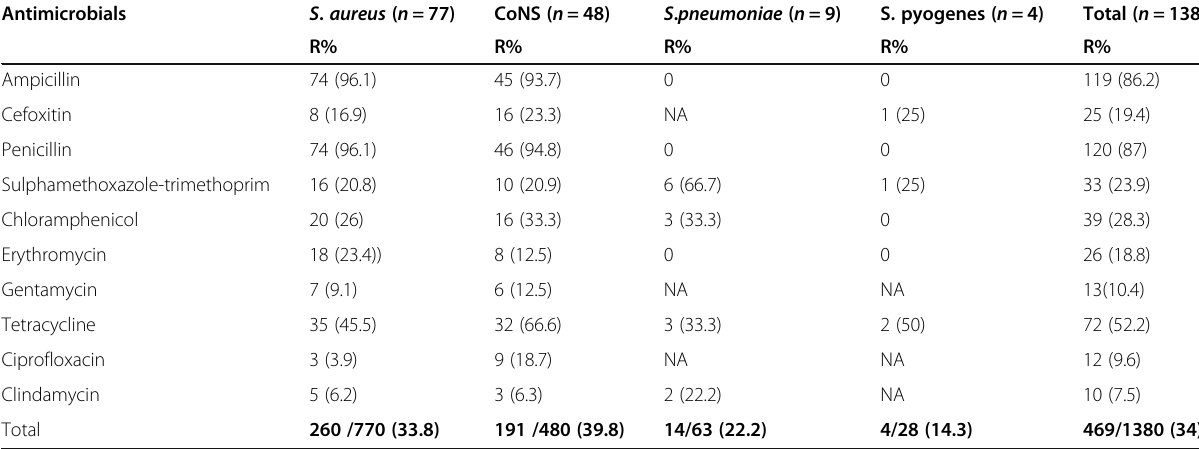
Table 4 Antimicrobial resistance profiles of Gram positive isolates from external ocular infections at Felege Hiwot Referral Hospital, 2019 Antimicrobials